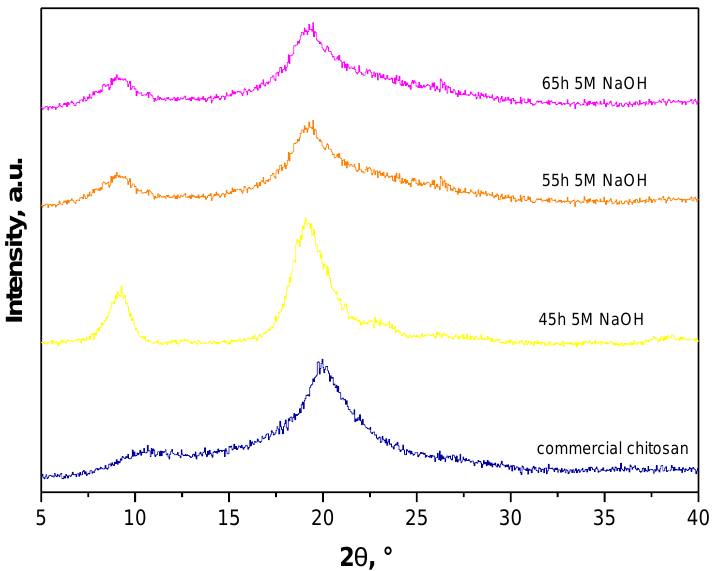
Figure 6. X-ray diffractograms of commercial polysaccharide (blue line) and selected samples after deproteinization process.